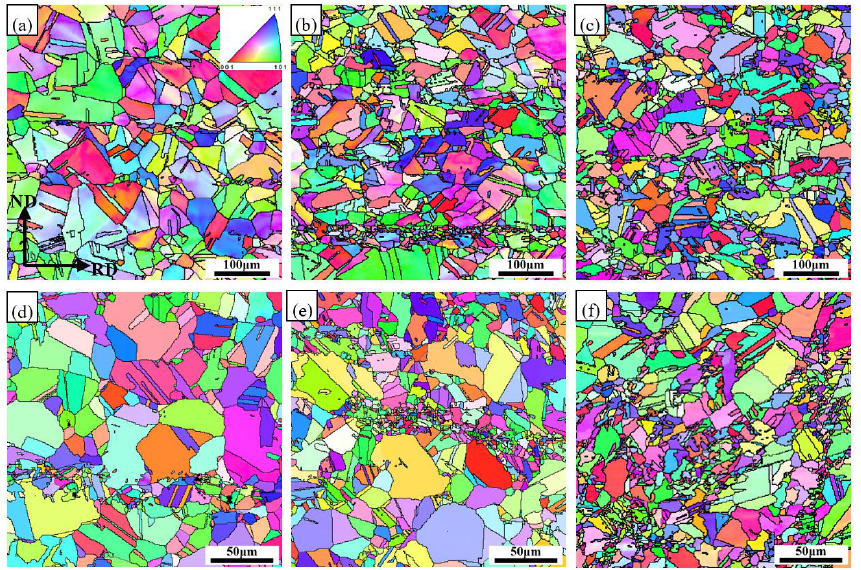
Figure 3. IPF maps of C276 superalloy annealed at 1050 ◦ C for 30 min with different cold rolling reductions. ( a ) 5%, ( b ) 10%, ( c ) 15%, ( d ) 20%, ( e ) 30%, ( f )